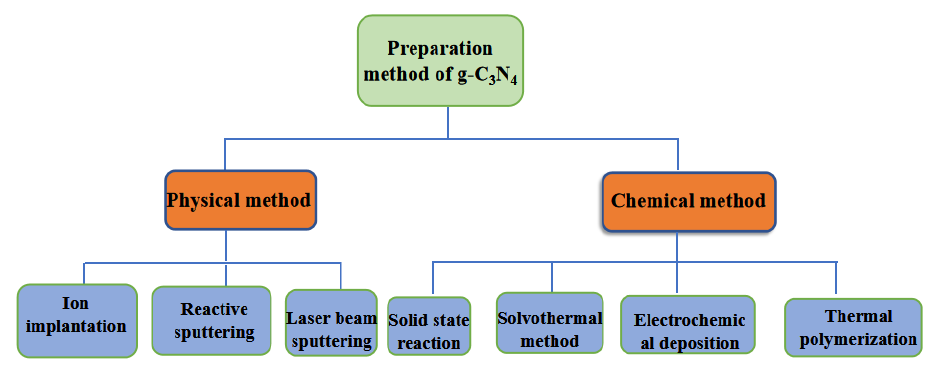
Figure 3. Graphical preparation of g-C 3 N 4 .